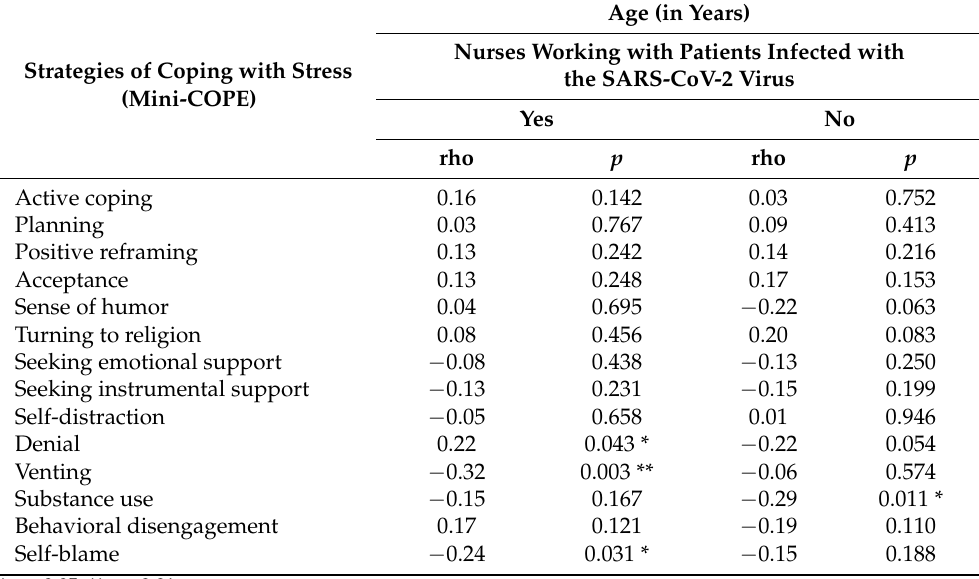
Table 4. Spearman’s rank correlation coefficient between strategies of coping with stress and nurses’